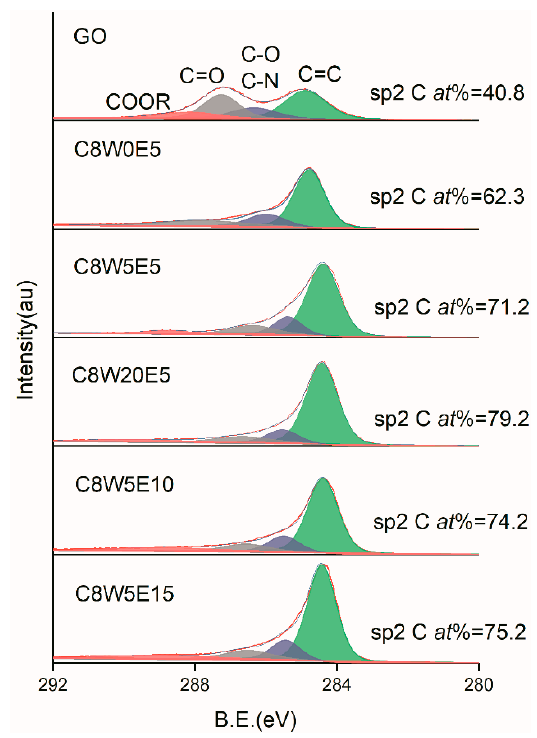
Figure 5. C1s X-ray photoelectron spectroscopy (XPS) fitting curves of different samples.